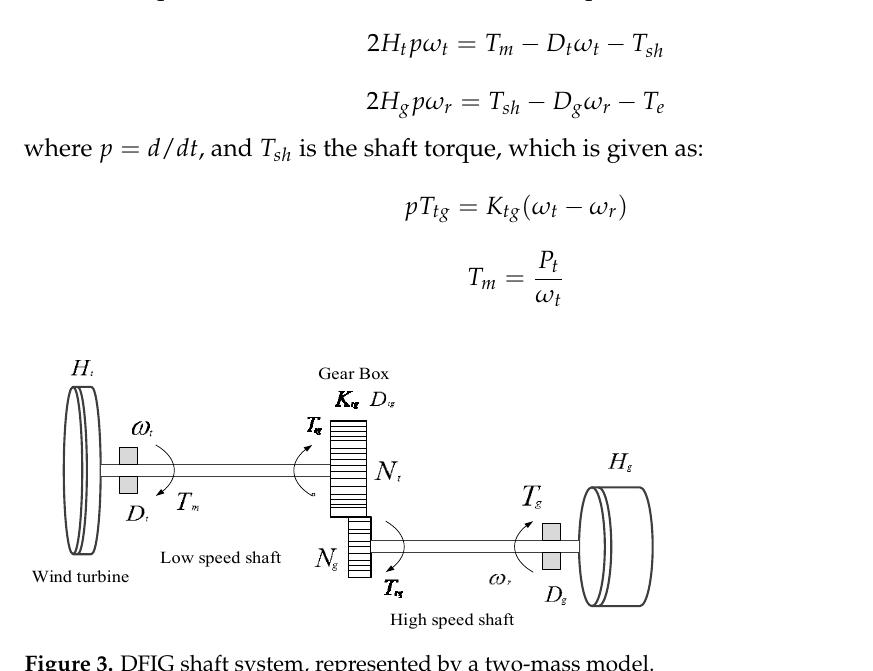
Figure 3. DFIG shaft system, represented by a two-mass